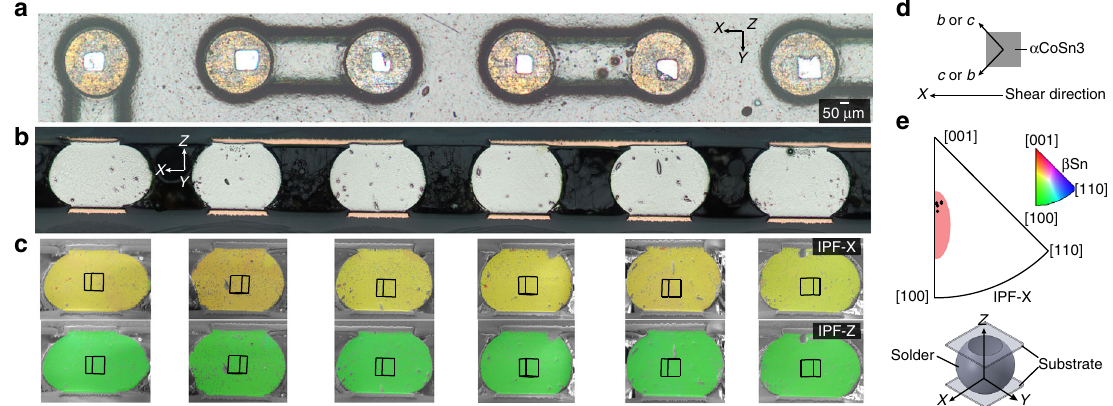
Fig. 7 Combined c -axis and a -axis orientation control in Cu/Sn-3.5Ag + α CoSn 3 /Cu joints. a α CoSn 3 particles transient liquid phase bonded onto an array of immersion tin-coated Cu pads. All seed crystals are aligned to have their c / b -axis in the XY plane and at ~45° with the X direction. b , c Cross-sections of Cu/Sn-3.5Ag + α CoSn 3 /Cu joints after double re fl ow on the seeded substrates in a . b Optical micrographs. c EBSD IPF-X and IPF-Y maps. d Schematic of the orientation of the α CoSn 3 particle with respect to the coordinate system and the shear direction. e IPF-X of all solder joints in b , c . The red region is the range of orientations reported to give the best shear fatigue performance in ref.